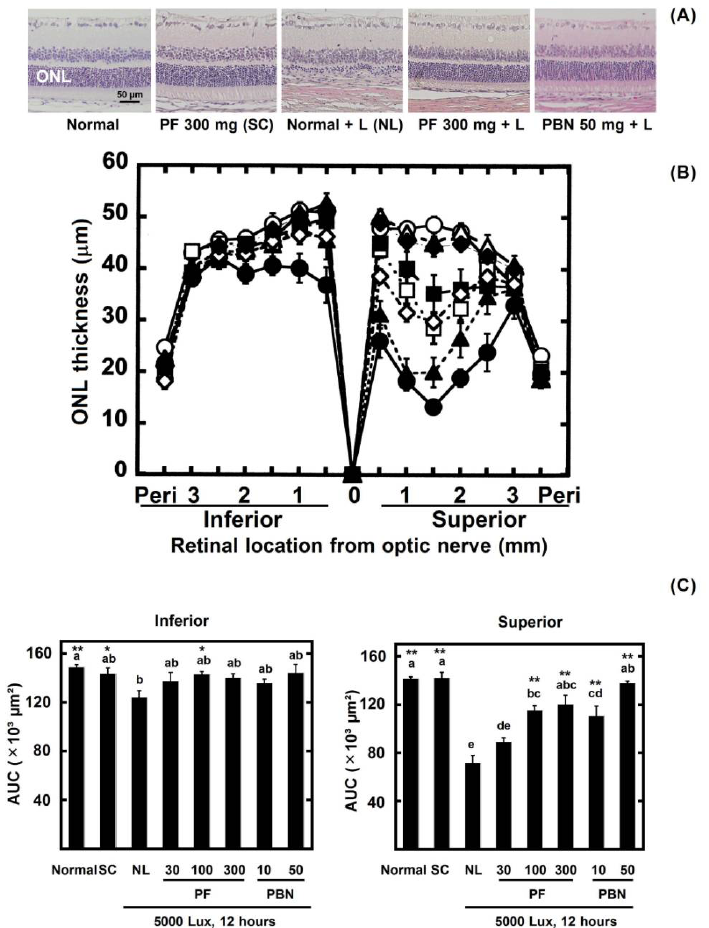
Figure 3. Protective effect of PF against light-induced retinal histologic damage. After ERG measurement, the ONL thickness was measured in the retinal sections. ( A ) Representative Hematoxylin and eosin (H&E) staining of the retinal sections were 1 mm superior to the outer nuclear layer (ONH); ( B ) The ONL thickness in each experimental group is shown. The data are expressed as the mean ± standard error of the mean ( n = 6). Normal ( ○ ) indicates normal control, no light exposure, untreated; SC ( △ ) indicates sample control, no light exposure, administration of PF 300 mg/kg of body weight; NL (●) indicates negative control, light exposure, administration of solvent; PF 30 ( ▲ ) indicates light exposure, administration of PF 30 mg/kg of body weight; PF 100 (□) indicates light exposure, administration of PF 100 mg/kg of body weight; PF 300 ( ■ ) indicates light exposure, administration of PF 300 mg/kg of body weight; PBN 10 ( ◇ ) indicates light exposure, injection of PBN 10 mg/kg of body weight; PBN 50 ( ◆ ) indicates light exposure, injection of PBN 50 mg/kg of body weight; and peri indicates the periphery 100 µm from the superior and inferior edges of the retina; ( C ) Area under the curve (AUC) of Figure 3B. Left graph indicates inferior, right graph indicates superior. Data represent the mean ± SEM ( n = 6). These data show the results of analysis by Tukey’s method and Dunnett’s method. Alphabets (a, b, c, d, and e) indicate values that differ significantly between each group ( p < 0.05) tested by Tukey’s method. Asterisks indicate values that differ significantly to the negative control tested by Dunnett’s method (* p < 0.05, ** p <